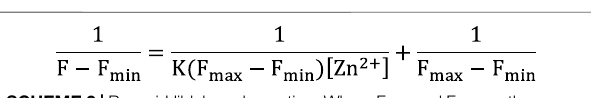
SCHEME 2 | Benesi-Hildebrand equation. Where F max and F min are the fl uorescence intensity of FPS in the presence and absence of zinc ions, respectively. F represents fl uorescent intensities (at 480 nm) of FPS as a function of Zn 2+ concentration. [FPS] (cid:2) 20.0 μ mol/L and [Zn 2+ ] (cid:2) 0 – 20 μ